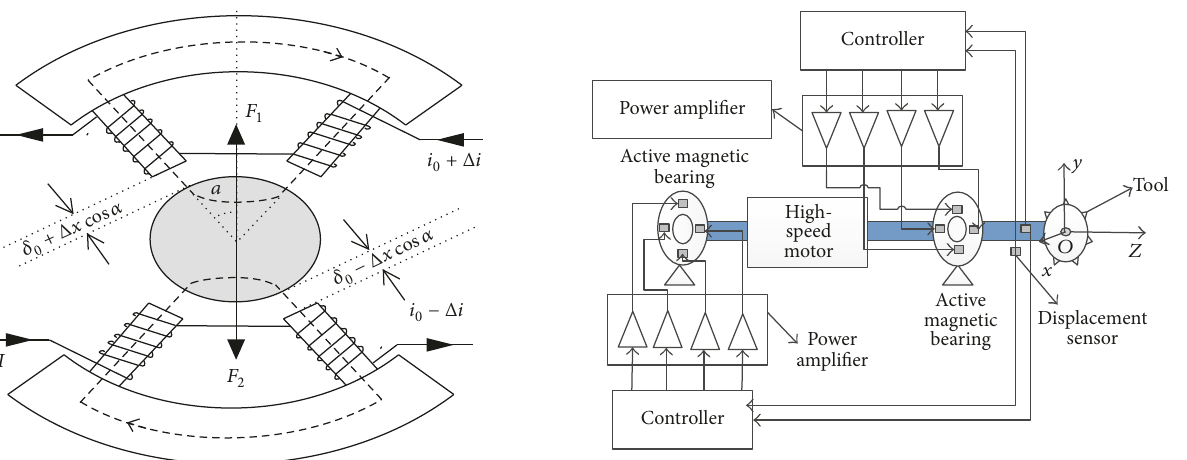
Figure 3: Active magnetic bearing differential structure.